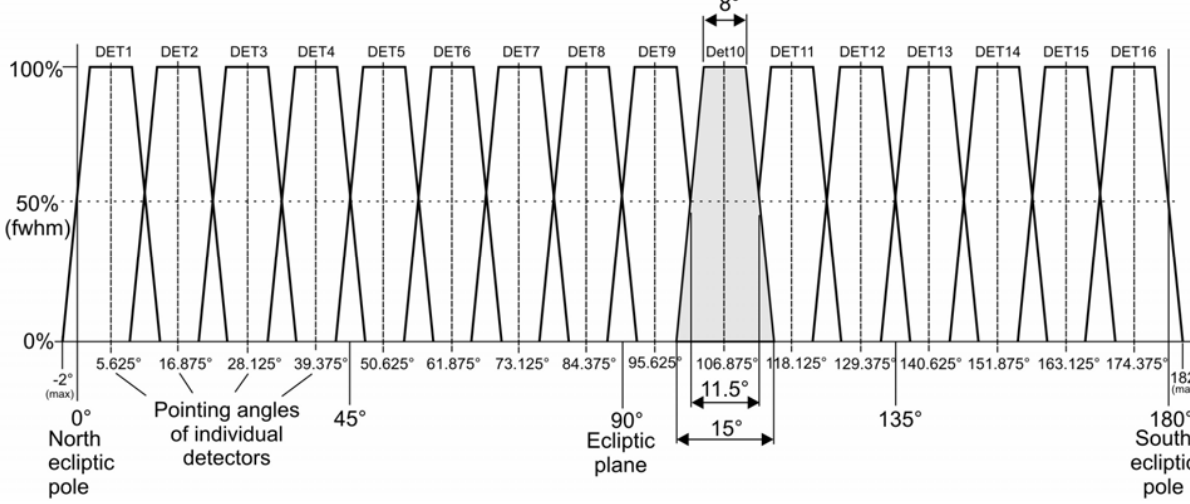
Fig. 4. Pointing angles and angular response of the 16 detectors in the elevation plane (the spacecraft spin axis points to the north ecliptic pole).